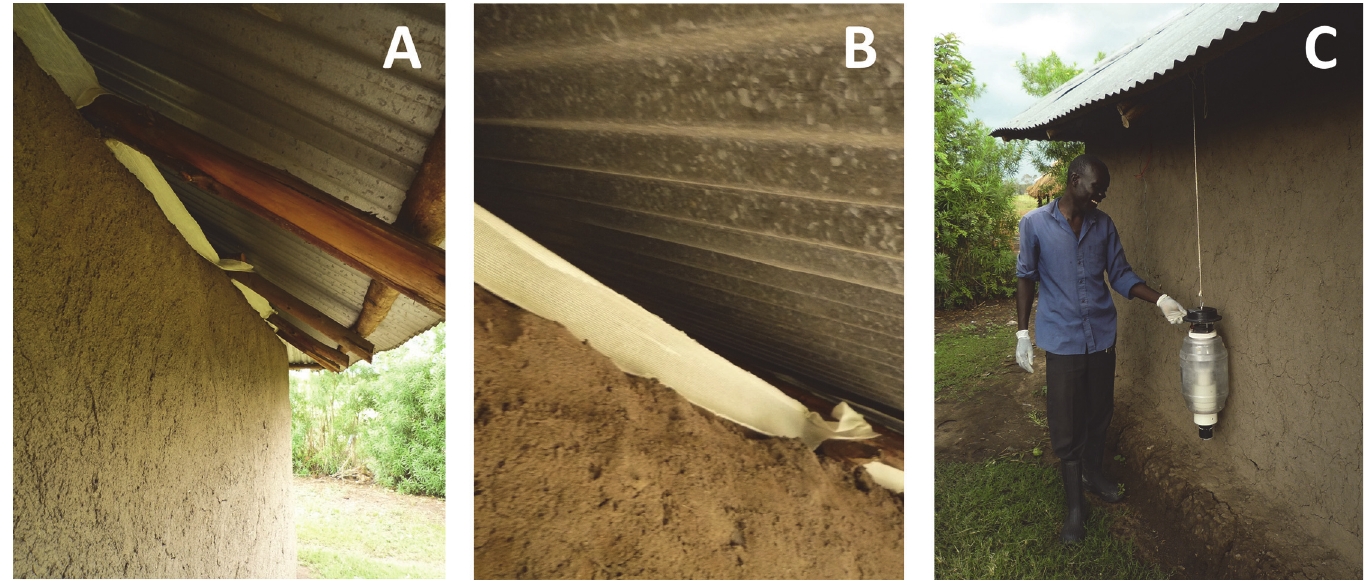
Fig 7. The components of the push-pull system. Panels A and B: The 10 cm wide strip of fabric as it was applied inside the eave, around the full circumference of the house. Panel C: The attractant baited MM-X trap as it was installed outside the house.